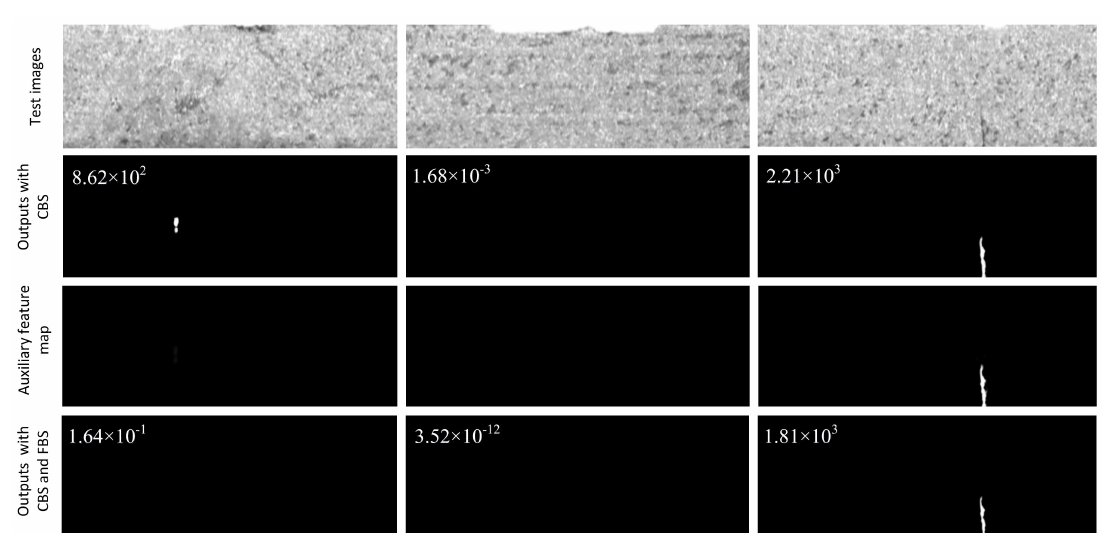
Figure 5. Fine background suppression (FBS).